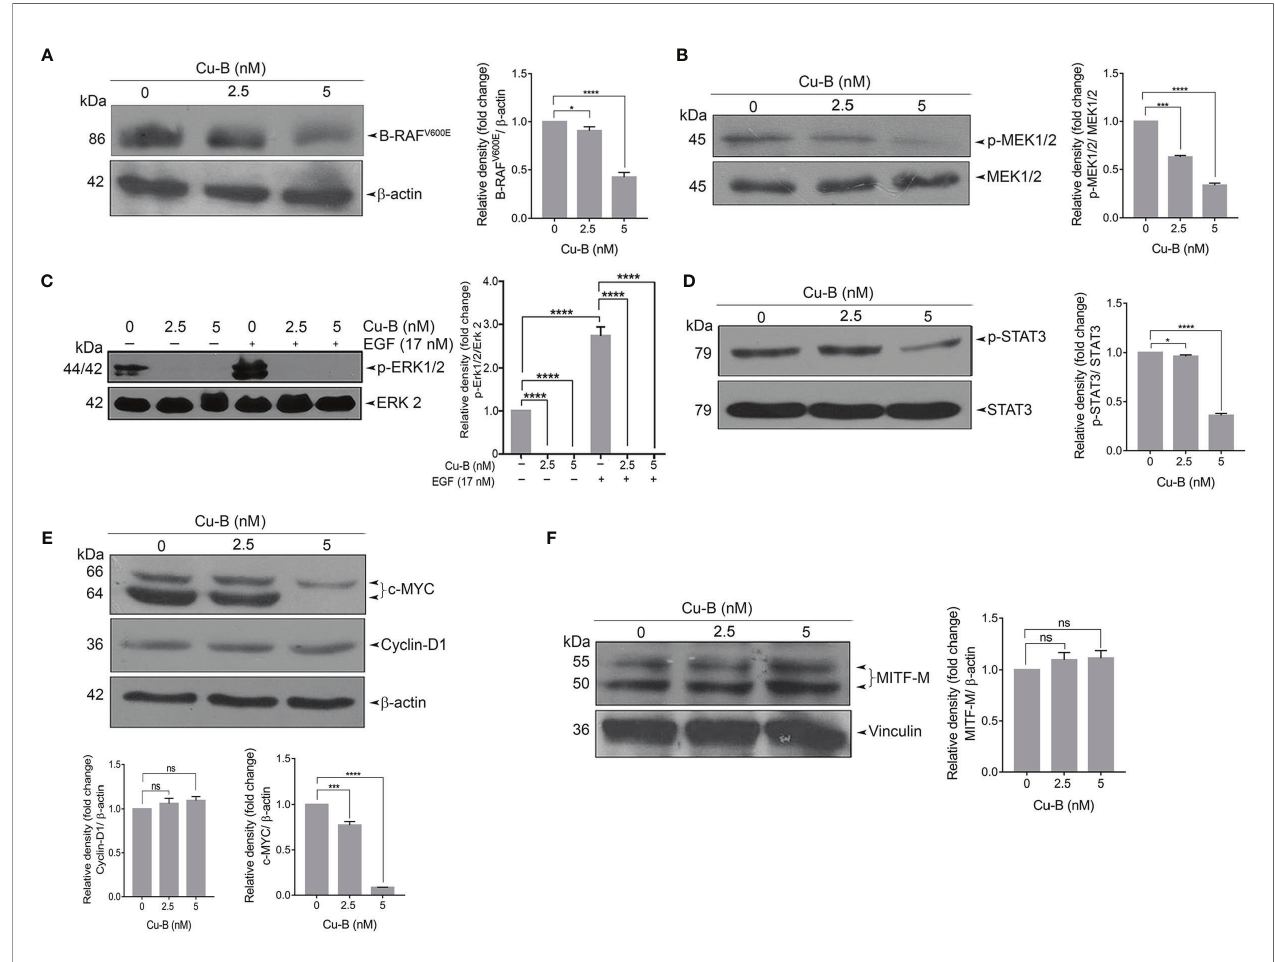
FIGURE 4 | The effect of Cu-B on the key survival signals in melanoma (A, B) Cu-B diminishes B- RAF V600E and p-MEK1/2 expressions in A375 cells. (C) Cu-B down-regulates the constitutive and EGF-induced phosphorylation of ERK1/2 in A375 cells. (D, E) Cu-B reduces the expressions of p-STAT 3 and c-MYC, but not Cyclin-D1, in A375 cells. (F) Cu-B treatment unalters MITF-M levels in A375 cells. Data are representative of three independent experiments (Mean±SEM) and P- values are calculated using one-way ANOVA. ****P ≤ 0.0001, ***P ≤ 0.001, *P ≤ 0.1and ns ≥